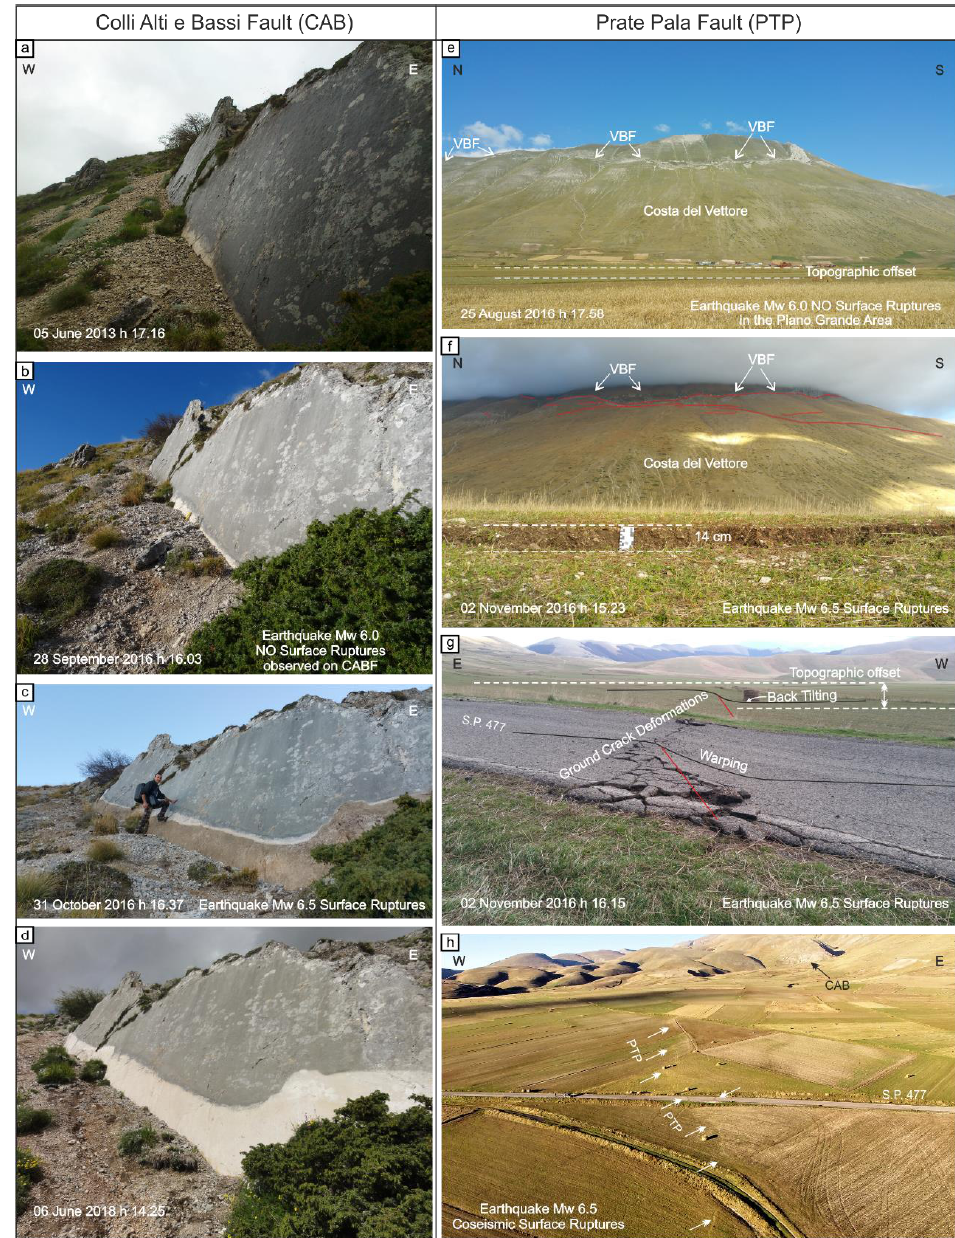
Figure 3. ( a – d ): Sample area 1—the same outcrop of the CAB fault scarp shooted at three temporal stages: ( a ) before the beginning of the 2016 seismic sequence, ( b ) after the 24 August and 26 October events but before the 30 October one, and ( c , d ) after the 30 October mainshock (bottom left on each image, date and the hour of photo shooting) ; ( e – h ): sample area 2—images at different scales, of the coseismic surface effects of the 30 October mainshock along the PTP fault